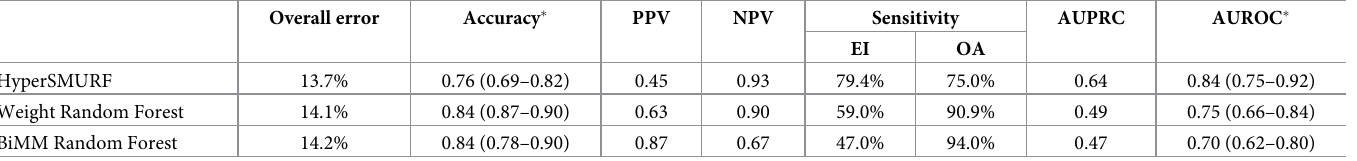
Table 3. Evaluation of the performance of the predictive